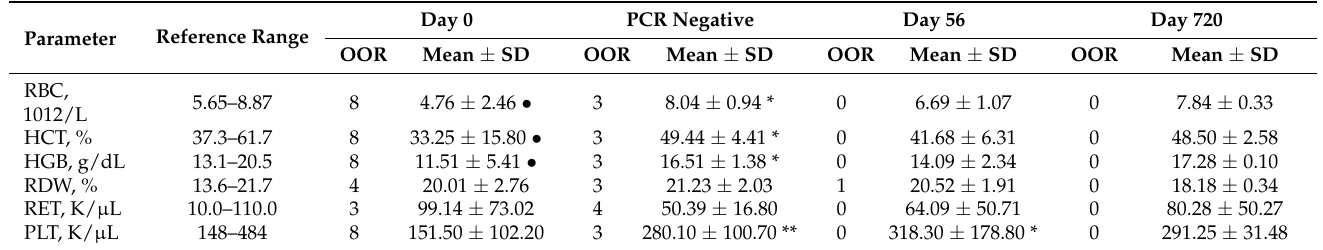
Table 1. Hematological and biochemical parameters in 12 dogs showing clinical remission for babesiosis following treatment with Malarone ® , azithromycin and artesunate